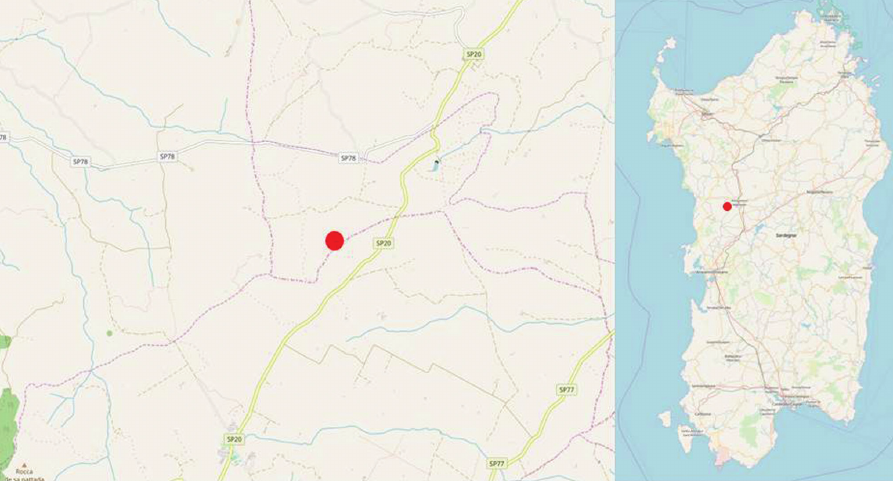
Figure 6. Geographic range and distribution map of Platanthera kuenkelei H.Baumann subsp. kuenkelei in